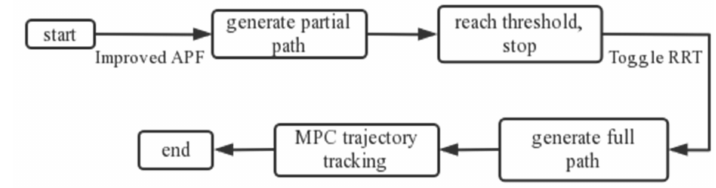
Figure 6. Algorithm combination process.